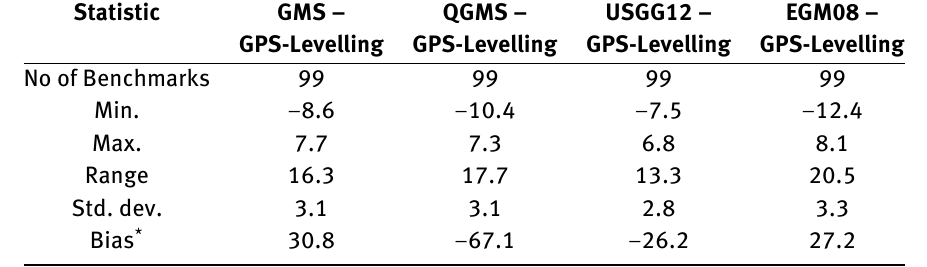
Table 3: Statistics of the differences between the different geoids and GPS-levelling benchmarks for the Louisiana test area. Unit is in cm